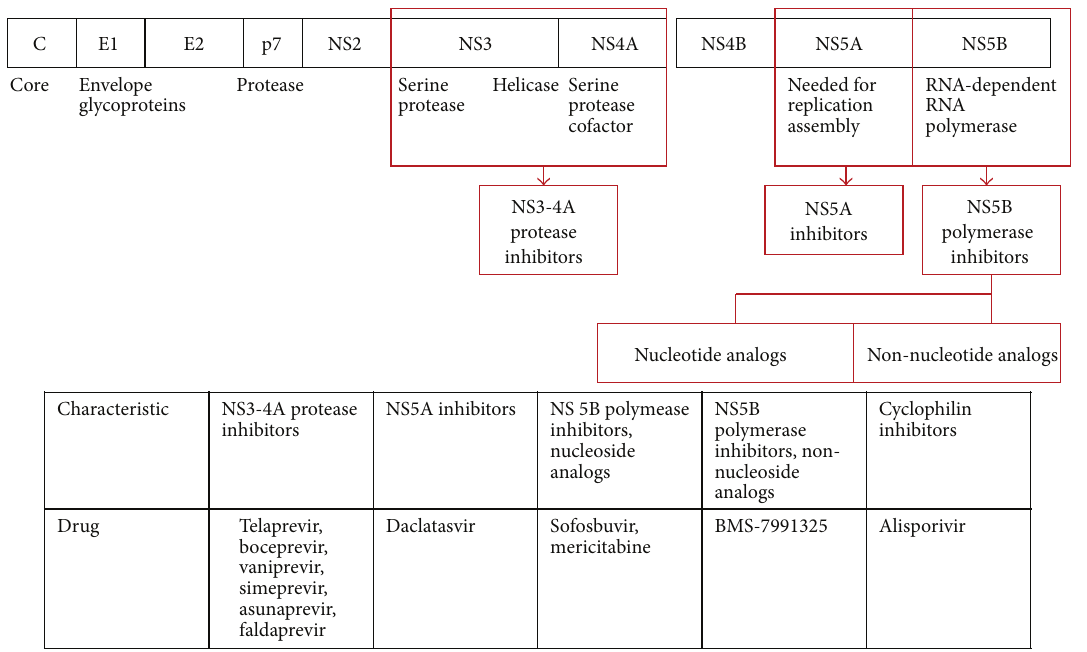
Figure 1: Targets for direct-acting antivirals. Modified from